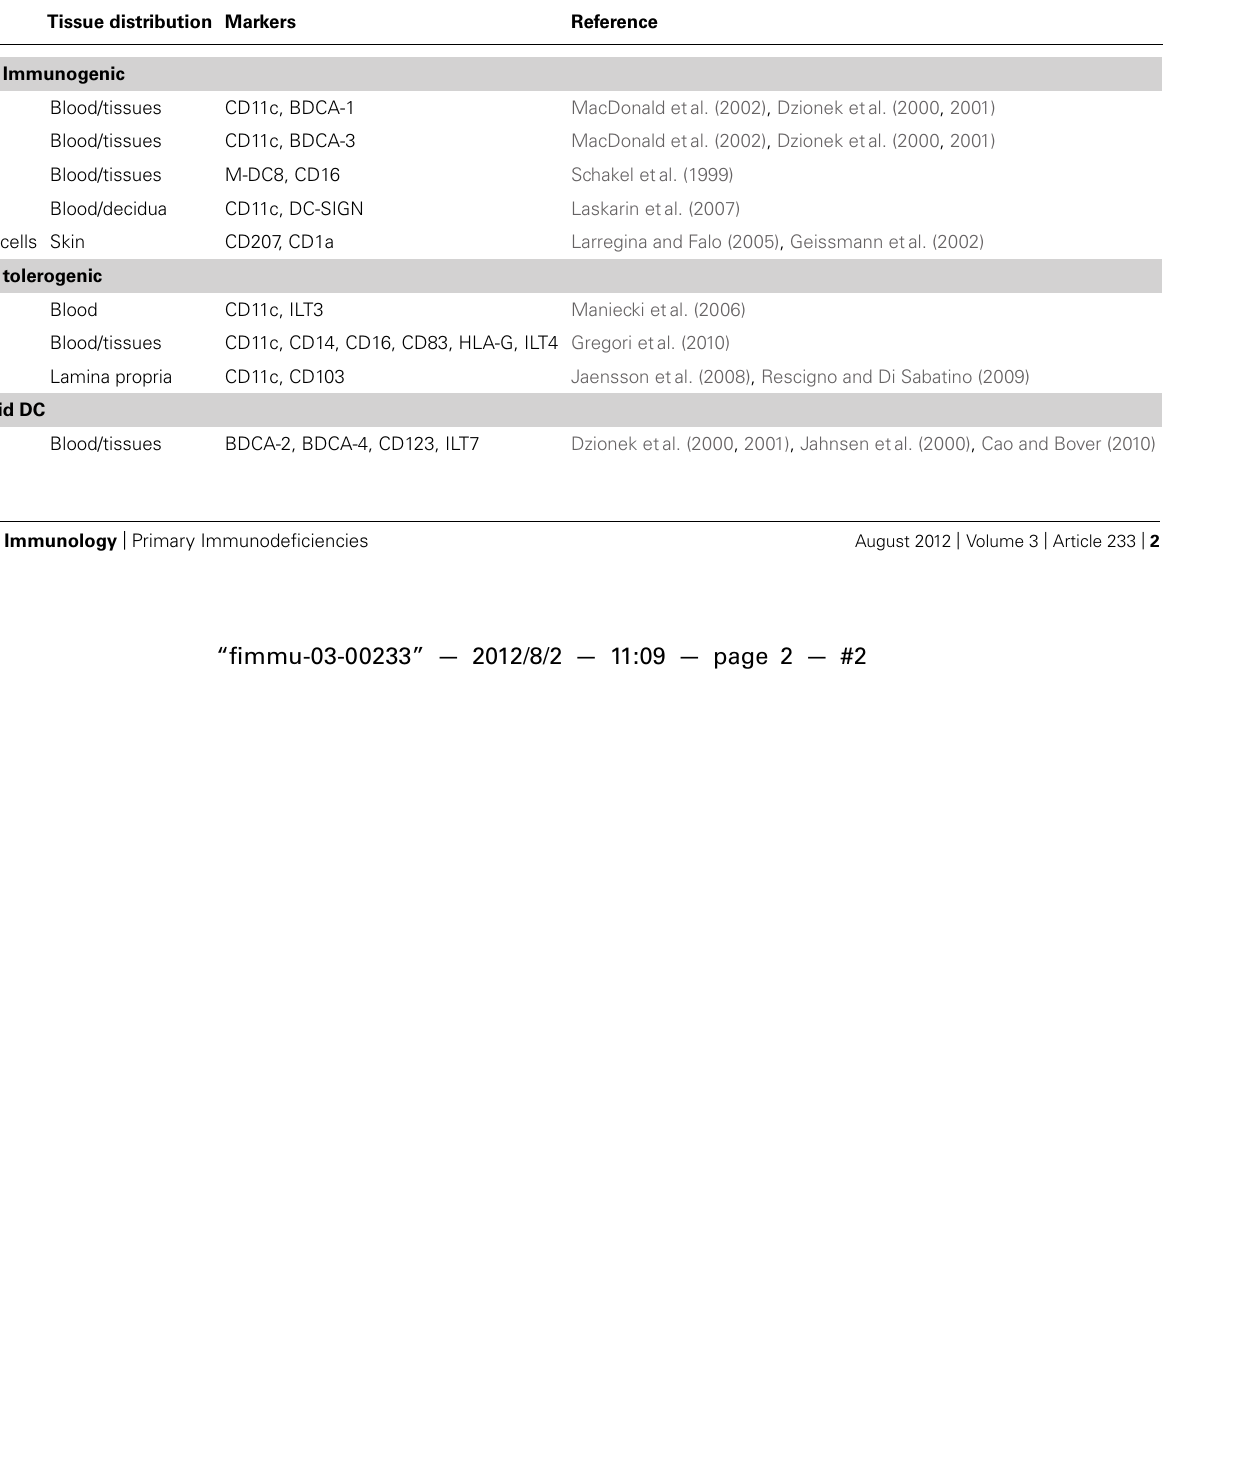
Table 1 | Different subsets of human dendritic cells. Tissue distribution